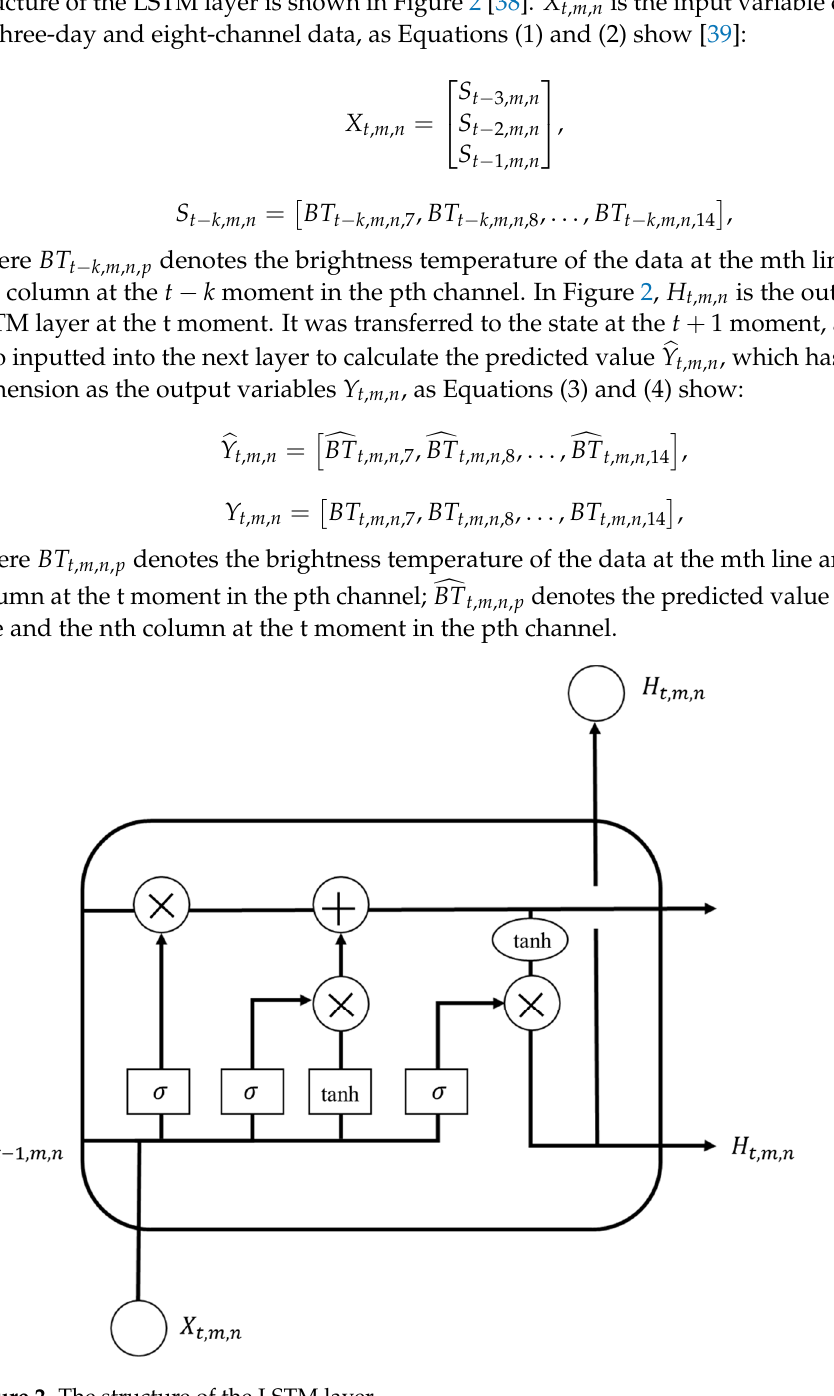
Figure 2. The structure of the LSTM layer.